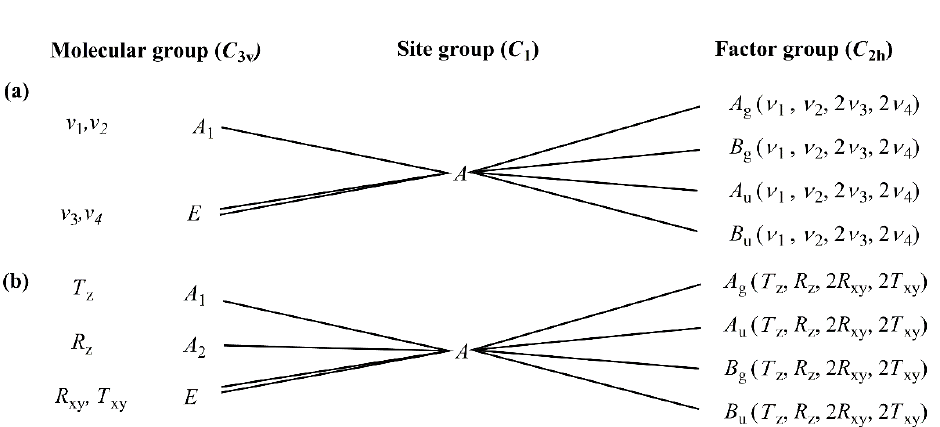
Figure 6. ( a ) Internal and ( b ) external ammonia vibrational modes in compound 1 . ν 1 —symmetric stretch.; ν 2 —symmetric bend.; ν 3 —antisymmetric stretch; ν 4 —antisymmetric bend.